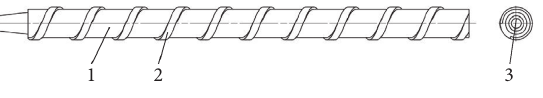
Figure 1: Sketch of rib drill ripe.